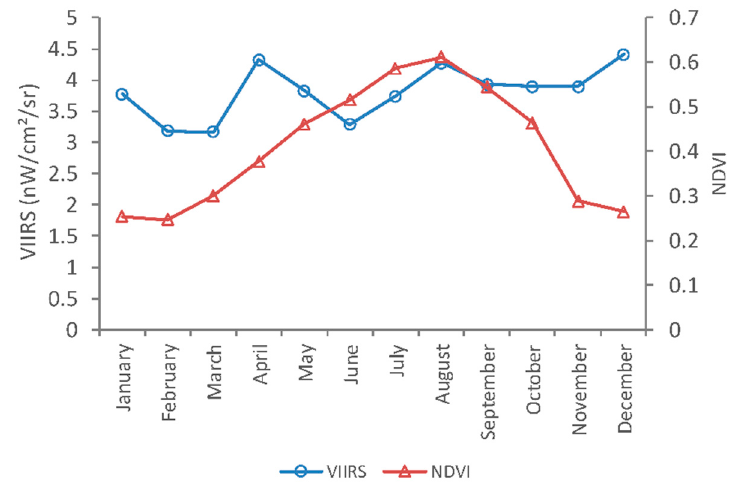
Figure 7. Monthly mean VIIRS nighttime brightness, NDVI in 2015.